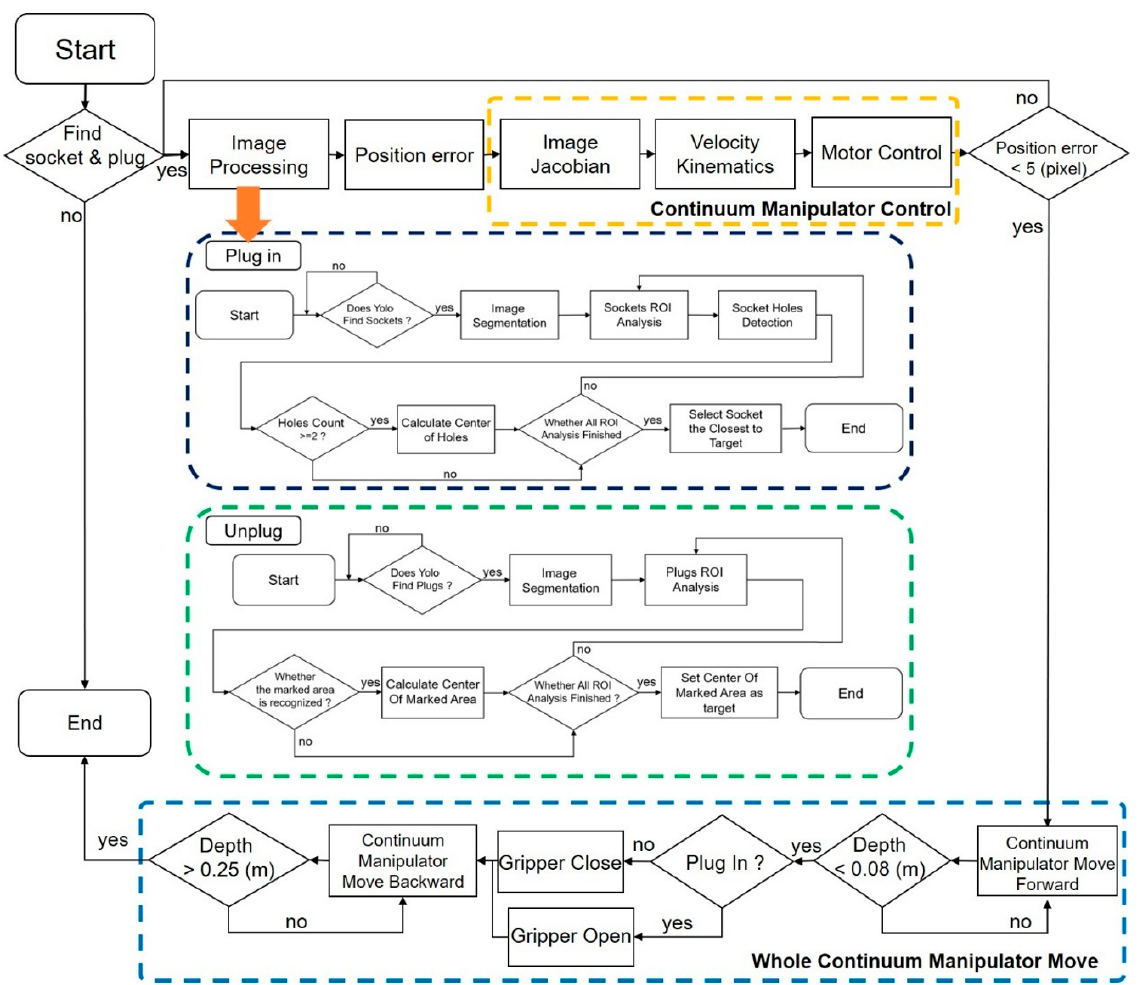
Figure 17. Environment for the plugging/unplugging experiment.